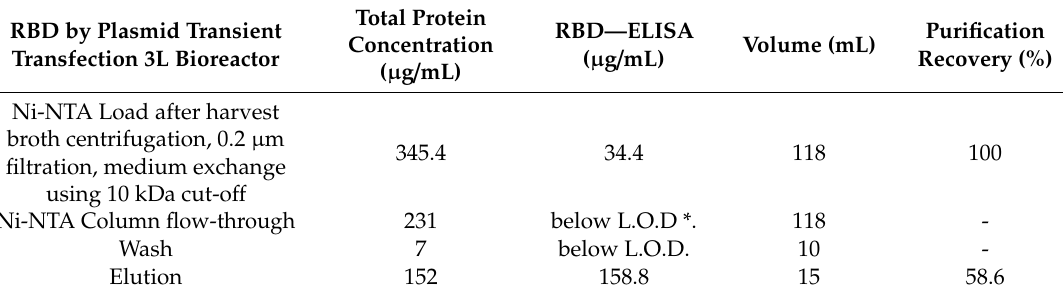
* LOD: Limit of detection. Both antigens (the one obtained by plasmid transfection and the one obtained after adenovirus infection) were detected in western blot analysis with an anti-Spike S1 monoclonal antibody